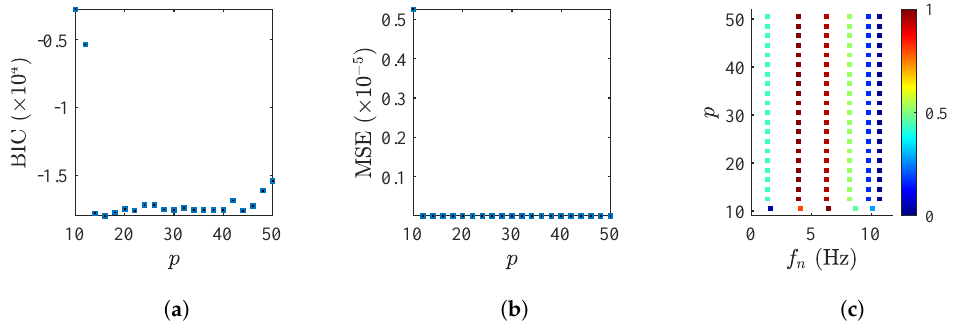
Figure 18. Shear frame: performance of the ARX model order selection criteria: ( a ) BIC. ( b ) MSE. ( c ) Dispersion-corrected frequency stabilization diagram. Table 4. Shear frame: statistics of the percentage fitness to the short time estimation data set during ARX